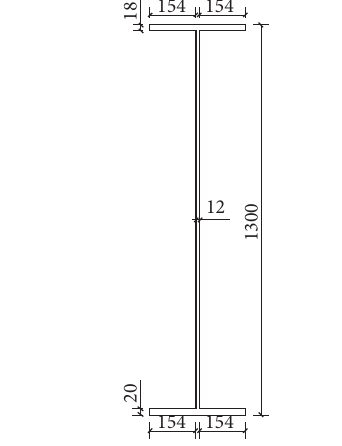
Figure 13: Diagram of a cross section of the small beam (unit: mm).